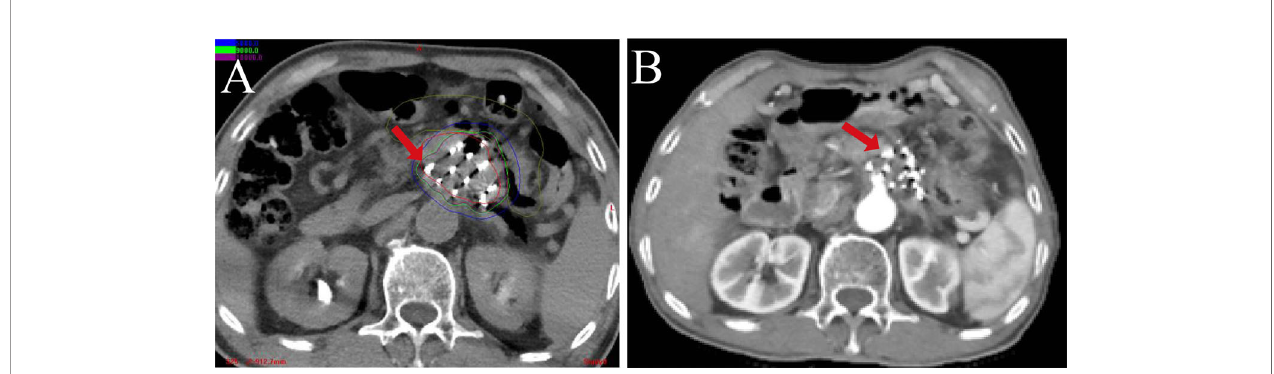
FIGURE 4 | The CT-scan image of 125I-RSI BT in pancreatic head cancer. (A) The postoperative actual dose distribution. (B) The postoperative follow-up at 6